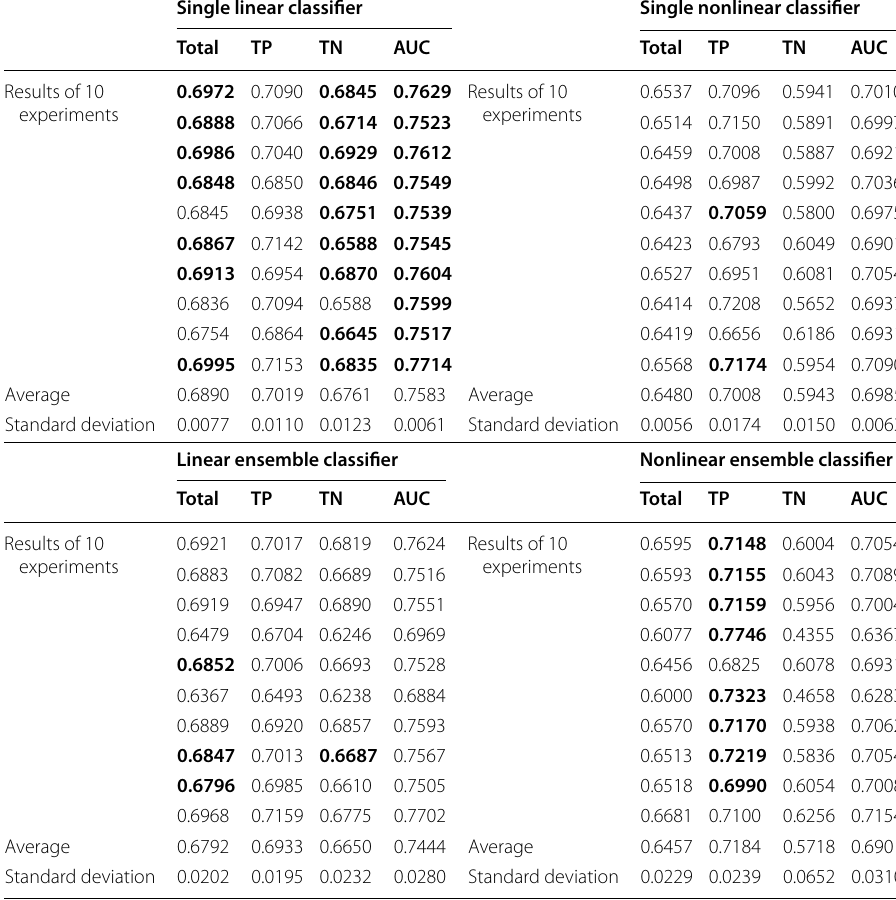
Table 3 Robustness analysis of classification with PCA in Kaggle dataset when 100 < feature dimensions < sample